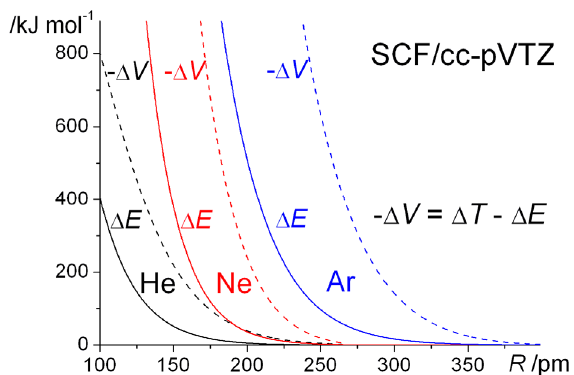
Figure 17. Helium (in black), neon (in red), and argon (in blue) dimers: total interaction energies ( ∆ E ), shown in full lines, computed at the simple mean field (SCF) level of theory using the correlation consistent triple zeta basis sets. Comparison with the respective potential ( − ∆ V) and kinetic components ( ∆ T – ∆ E ) shown by dashed lines.